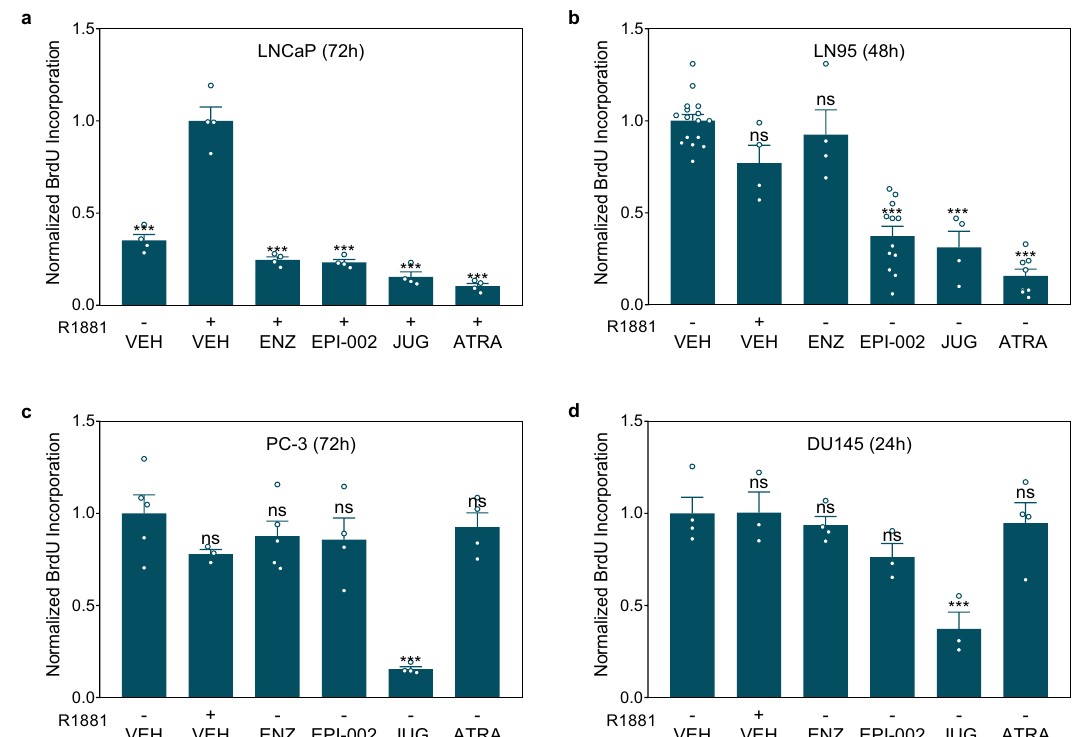
Fig. 4 ATRA suppresses prostate cancer cell proliferation driven by full-length AR and AR-Vs. a – d Proliferation assays showing the effect of AR inhibitors (ENZ, 10 µ M; and EPI-002, 25 µ M) and Pin1 inhibitors (JUG, 20 µ M; and ATRA, 10 µ M) on BrdU incorporation of the indicated prostate cancer cell lines: LNCaP ( a androgen-sensitive); LN95 ( b androgen-independent); PC-3 and DU145 ( c and d , AR non-reliant). Cells were treated with the inhibitors and stimulated with 1 nM of R1881 ( + ) or vehicle ( − ) for 24 to 72 h. Each data point represents the average from an independent experiment where the error bars show the mean ± s.e.m. Statistical signi fi cance was determined by one-way ANOVA using Dunnett ’ s multiple comparisons test. * P < 0.05, ** P < 0.01, *** P < 0.001; ns not signi fi (Fig. 5a). Consistent with blocking AR NTD transcriptional toxicity pro fi les, we focused on this compound in combination activity, ralaniten, Pin1 inhibitors, and Pin1 knockdown all with ralaniten and a second-generation analog EPI-7170 that has decreased AR-V7-induced reporter activity (Fig. 5a, b). Western improved potency 37 . The impact of a suboptimal concentration of ATRA (5 μ M) on dose – response curves for ralaniten and EPI- blot analyses revealed similar levels of AR-V7 between the dif- 7170 for inhibiting androgen-induced PSA(6.1 kb)-luciferase ferent treatments and siRNAs (Fig. 5c, d). Collectively, these activity was determined. The IC 50 of ralaniten for PSA(6.1 kb) results imply that the isomerase activity of Pin1 impacts AR-V7 transcriptional activity through the AR NTD.